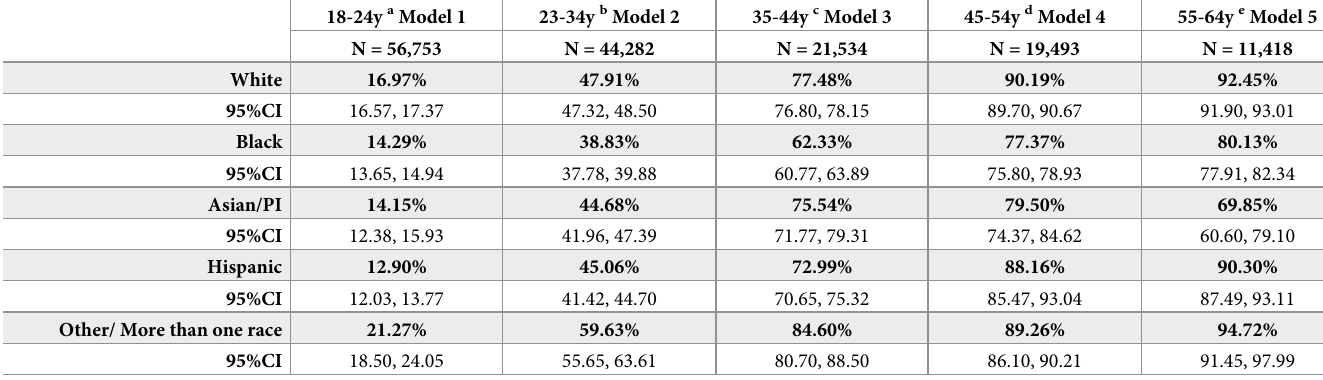
Table 2. Predicted probability of being full-dual eligible by race-ethnicity for autistic adults across the lifespan.